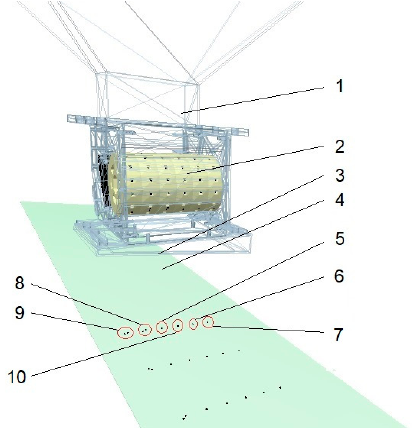
Figure 3. Simulation model: (1) shell, (2) seed-metering mechanism, (3) mounting frame, (4) conveyor belt, (5) 3rd row, (6) 5th row, (7) 6th row, (8) 2nd row, (9) 1st row, (10) 4th row.